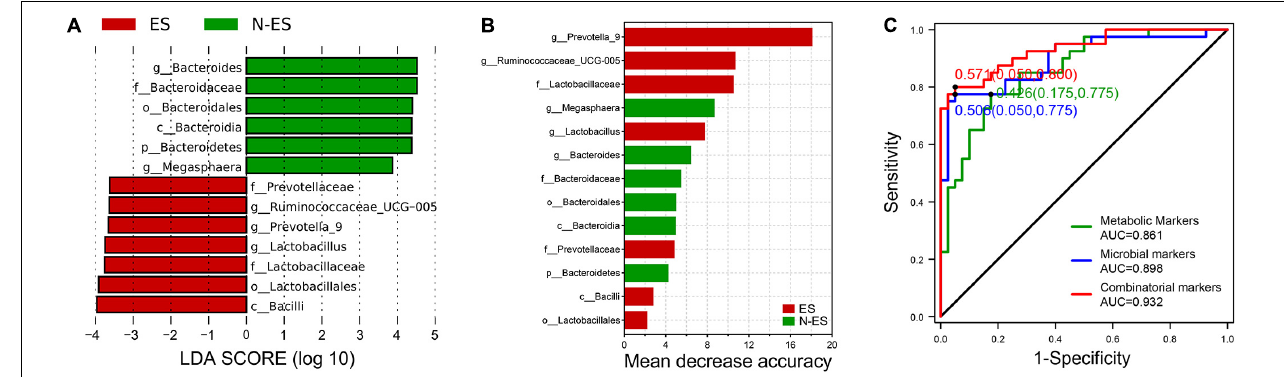
FIGURE 6 | Multiple markers obtained for monitoring the potential of soldiers. (A) Microbial biomarkers obtained for identification of ES and N-ES cohorts. (B) The order of importance for these variables. The bar colors indicate enrichment in ES (red shades) or N-ES (green shades). (C) Classification performance of the random forest models based on metabolic markers (green), microbial markers (blue), and combinatorial markers (red) for ES and N-ES cohorts.